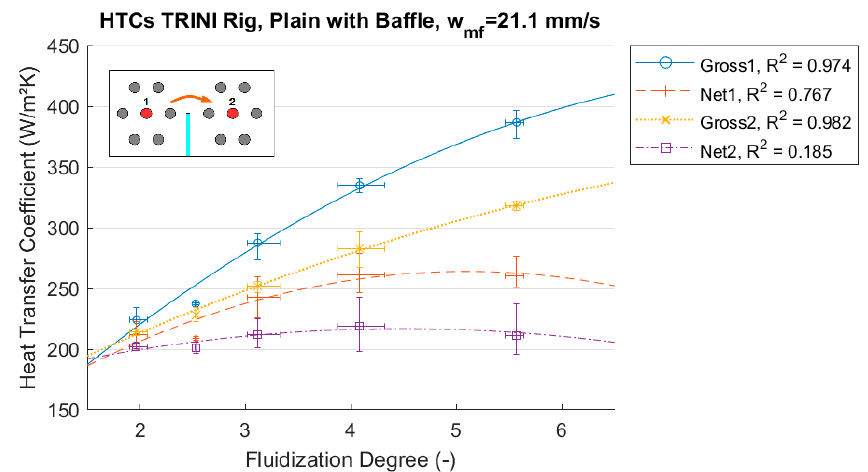
Figure 13. Plain tube results when using baffles, TRINI test rig, 146 µm particles. Indices 1 and 2 refer to the different heated tubes.